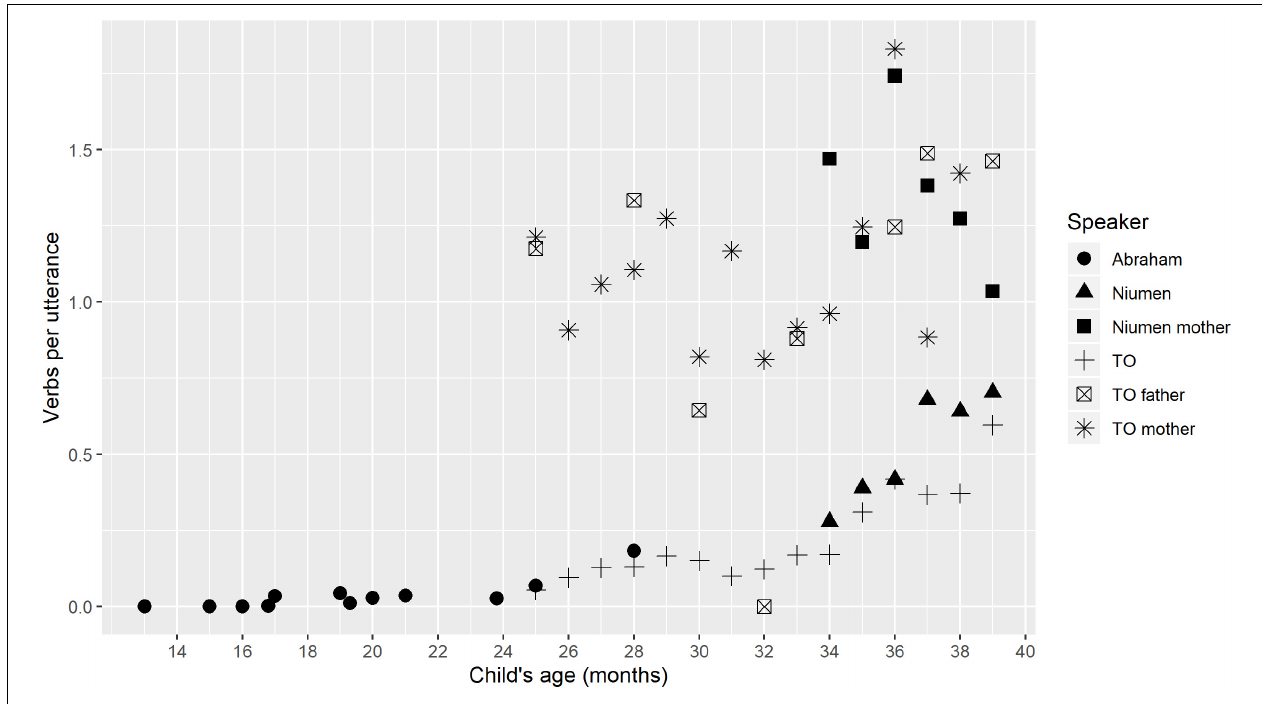
FIGURE 1 | Verbs per utterance by child’s